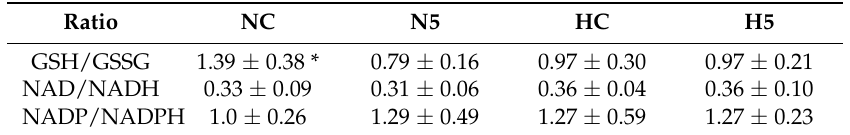
Table 7. Redox ratios in the liver of the rats of four experimental groups at the end of the intervention period 1